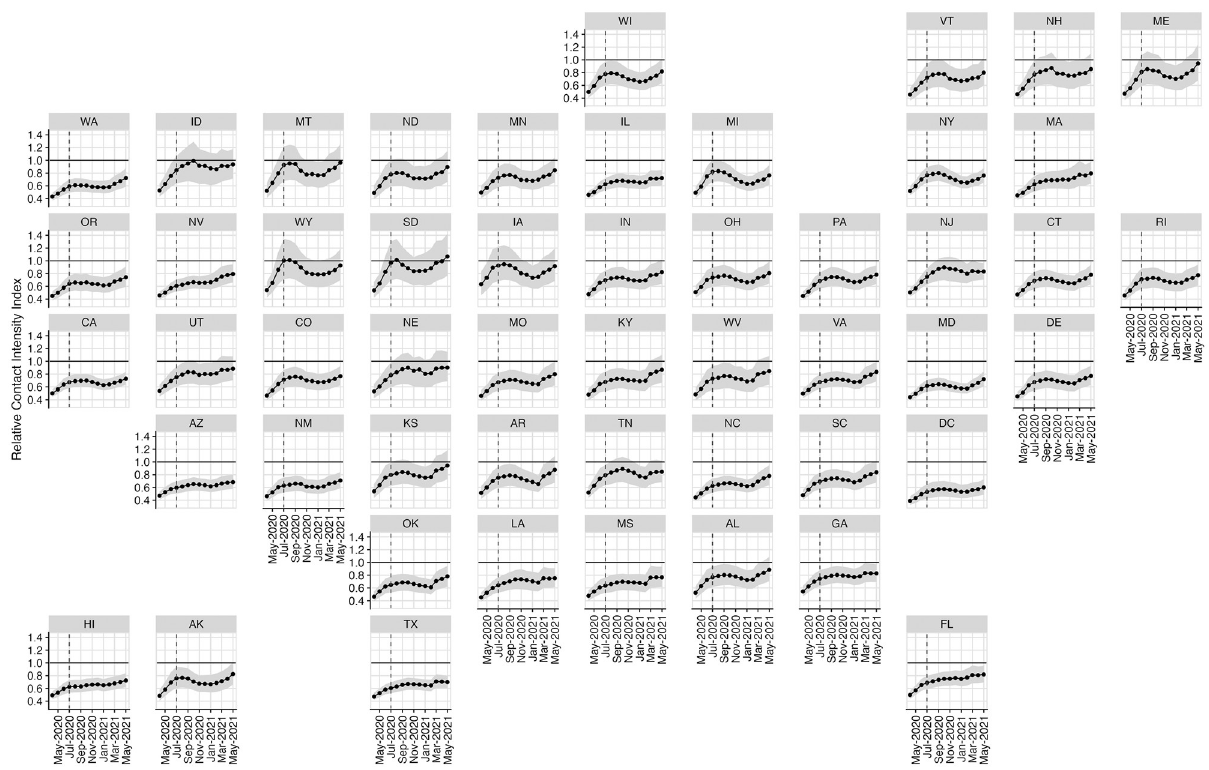
Fig 3. Monthly state-specific estimates of relative contact intensity index over time. Horizontal black line shows pre-pandemic baseline contact intensity. Vertical dashed line denotes July 2020, the month we present contact matrices for in Fig 2.